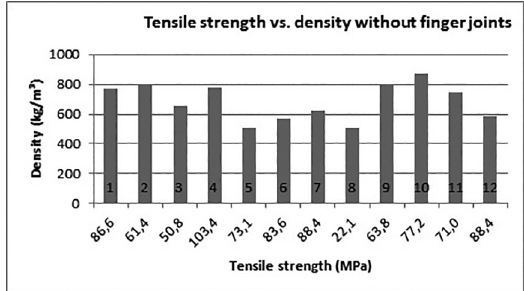
Figure 12: Chart comparing density to tensile strength for samples without finger